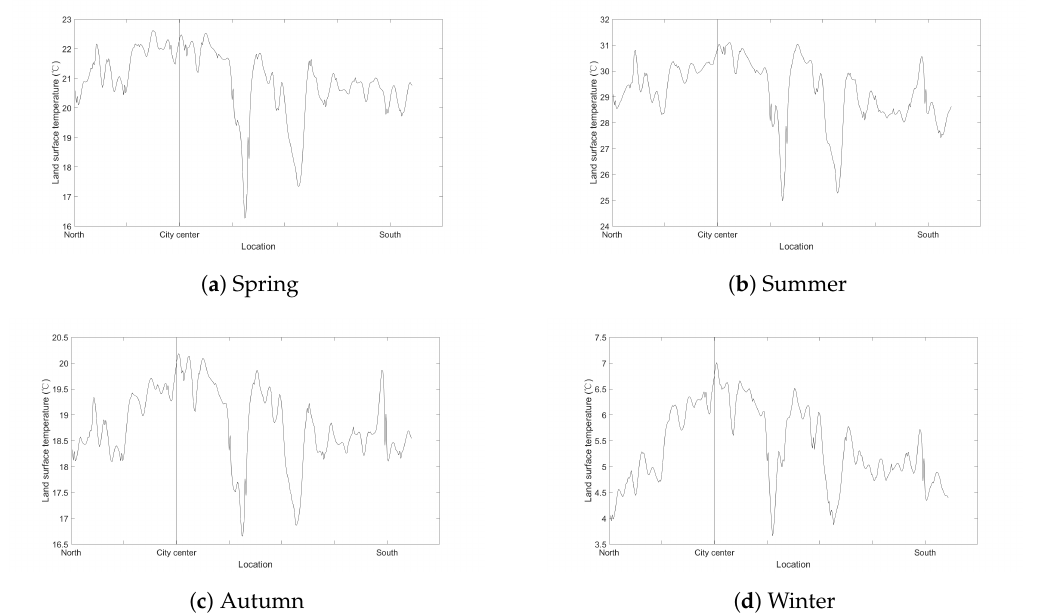
Figure 10. Seasonal land surface temperature ( ◦ C) along the north to south transect in